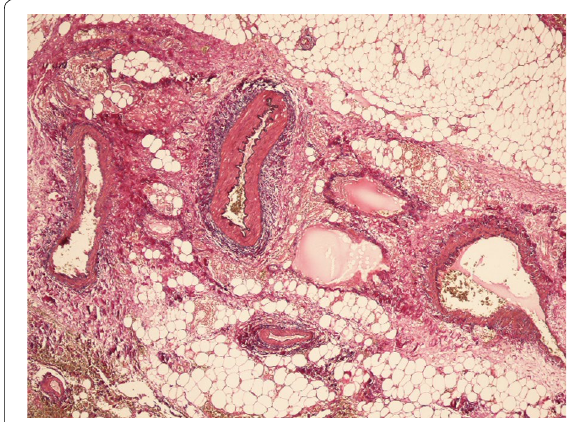
Fig. 5 Van Gieson’s EVG stain with loss of elastic lamina in blood vessels ( ×